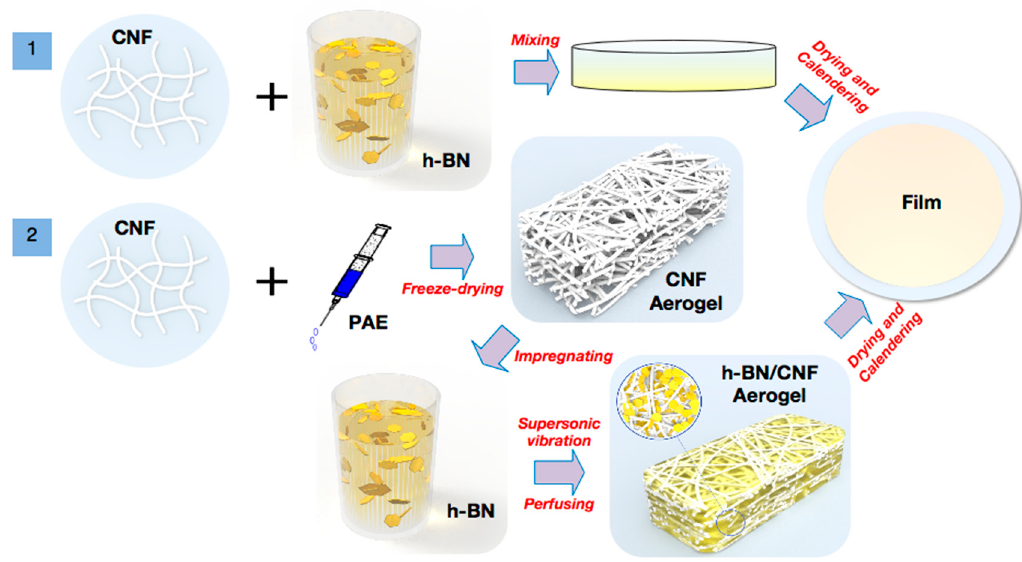
Figure 1. Schematic of preparation of hexagonal boron nitride/cellulose-nano fiber (h-BN/CNF) composite film.